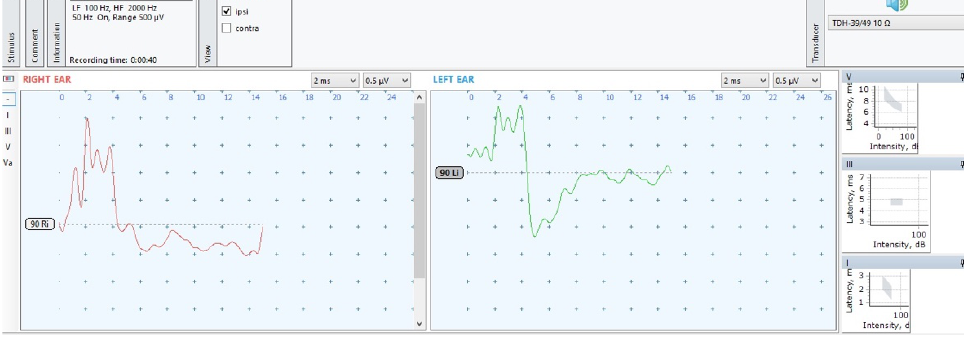
Fig. 4 Motion artifact